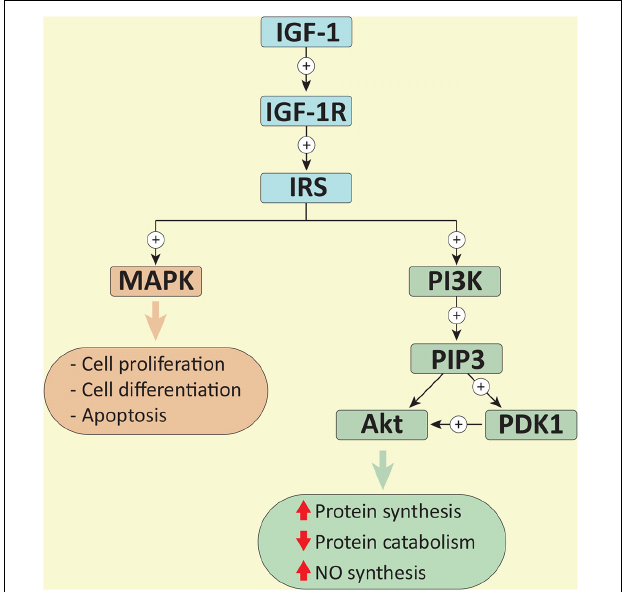
FIGURE 1 | Binding to the IGF-1 receptor (IGF-1R), IGF-1 begins a series of cascading processes. Activated IGF-1R mediates the recruitment and phosphorylation of insulin receptor substrate (IRS), and the activation of the mitogen-activated protein kinase (MAPK) pathway. Phosphorylated IRS also recruits and activates phosphoinositide 3-kinase (PI3K). By phosphorylating phosphoinositide-4,5-biphosphate, PI3K creates phosphoinositide-3,4,5-triphosphate (PIP3) and consequently two docking sites for the recruiting Akt and phosphoinositide-dependent kinase 1 (PDK1). PDK1 phosphorylates Akt, leading to its activation (Schiaffino and Mammucari, 2011; Bernardo et al.,